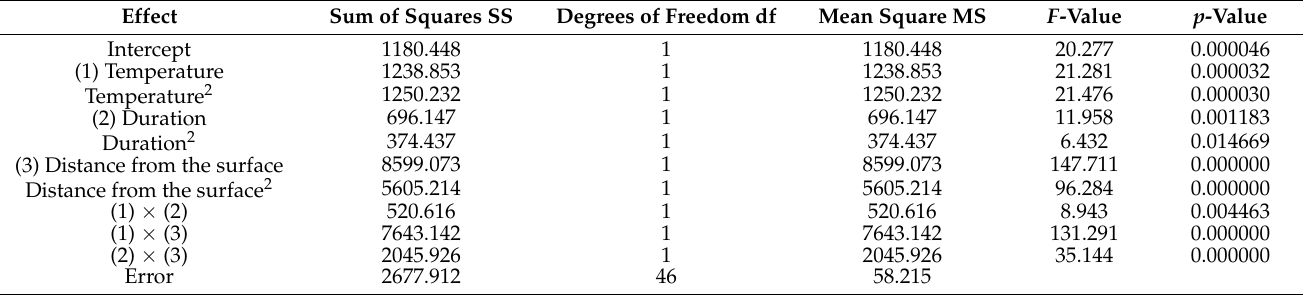
Table 6. Analysis of variance for the regression model of the volume fraction of the boride